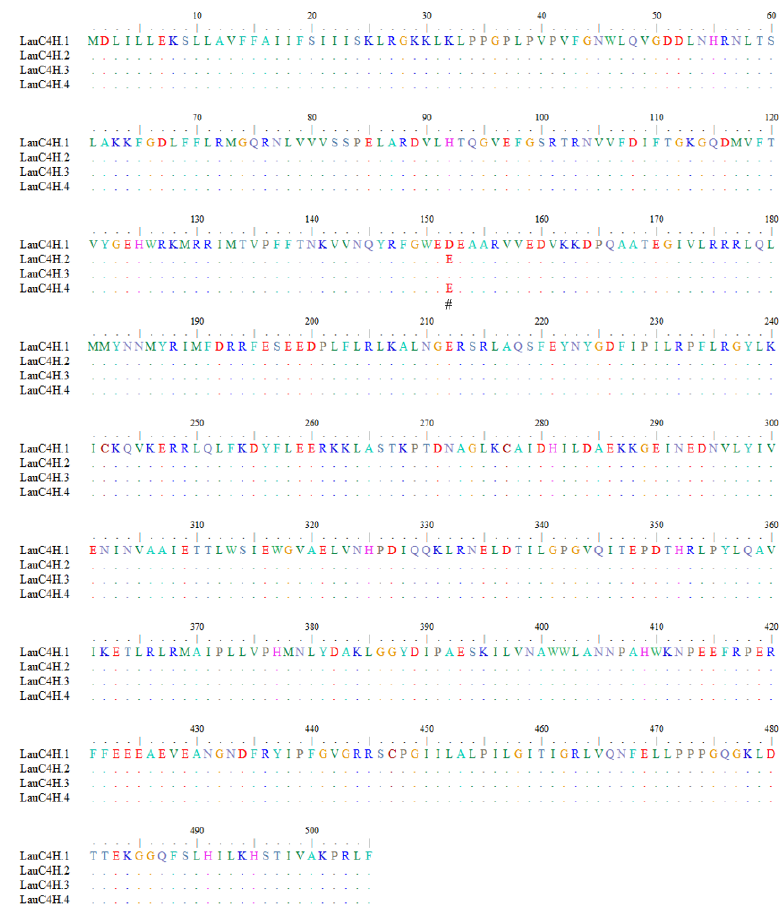
Figure A2. Protein sequence alignment of Lau C4H variants. Four unique variants of Lau C4H protein are aligned against the original sequence predicted by the de novo assembled transcriptome. Dots are identical residues. Molecules 2018, 23, x FOR PEER REVIEW 17 of 22